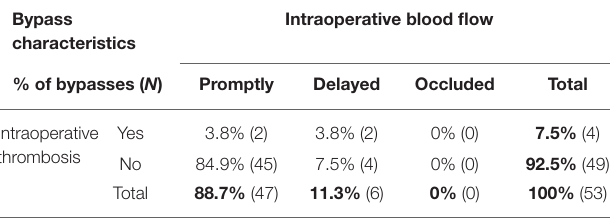
TABLE 2 | Bypass characteristics. Cross table showing percentage and number of bypasses in which an intraoperative temporary thrombosis (which was resolved before suturing the anastomosis) of the donor vessel was observed and bypass blood flow at the end of surgery.